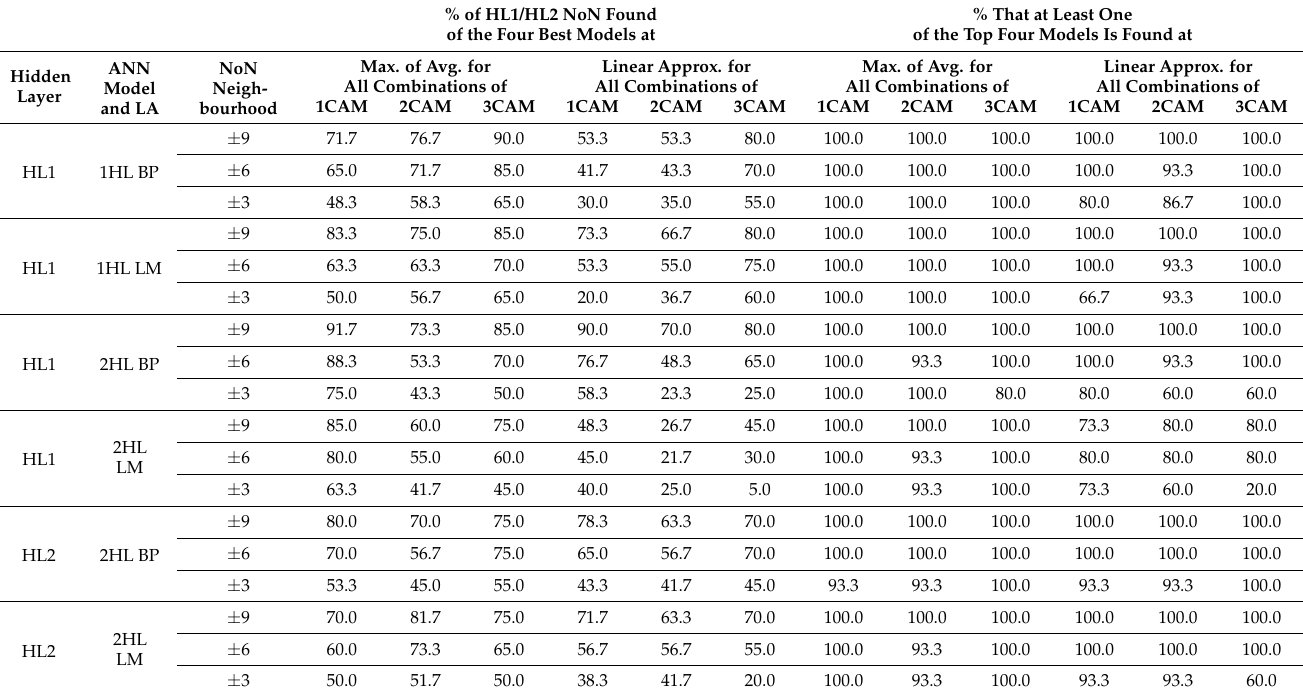
Table 2. Evaluation of the profiling performance of 1/2HL ANN for BP/LM learning algorithm (LA) with 1, 2, and 3 cameras in the percentage of the first four best models found and in the percentage of finding at least one in four best